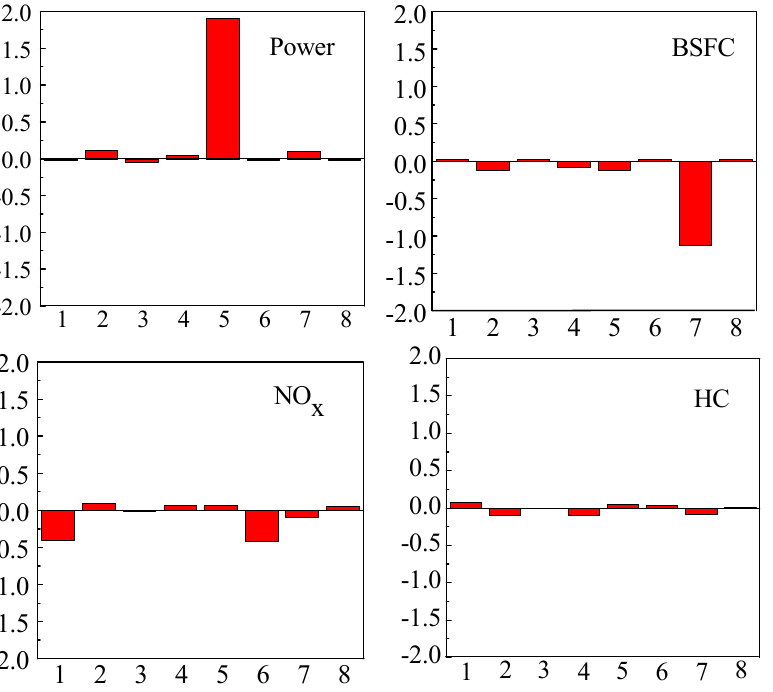
Figure 12. Comparisons of relative contribution on the engine characteristic in high speed (1000 rpm) and in lean operation zone (Equivalence ratio Φ =